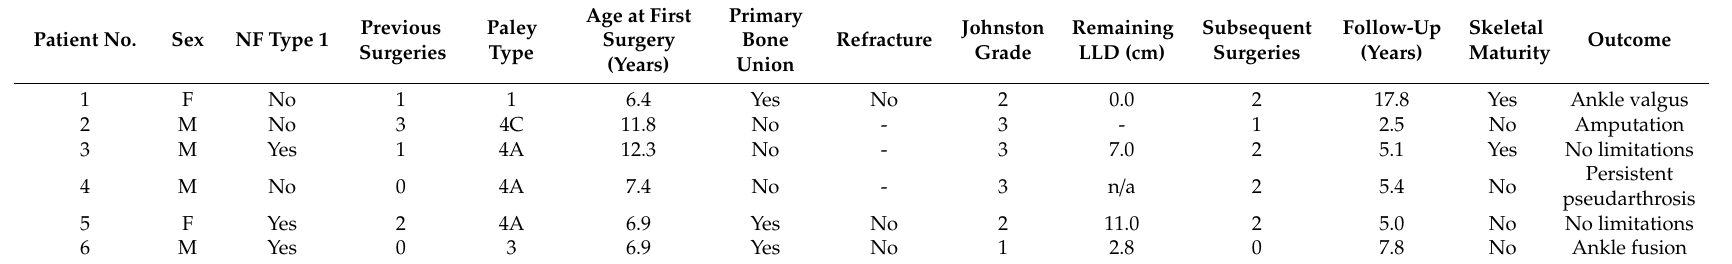
Table 1. Results Group A: Excision of the pseudarthrosis and bone transport.